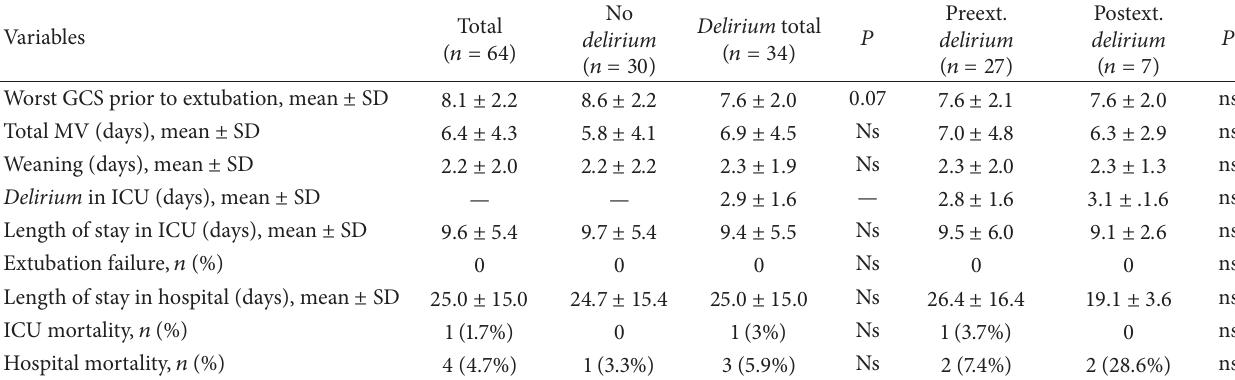
Table 2: Outcomes of patients with and without delirium before and after